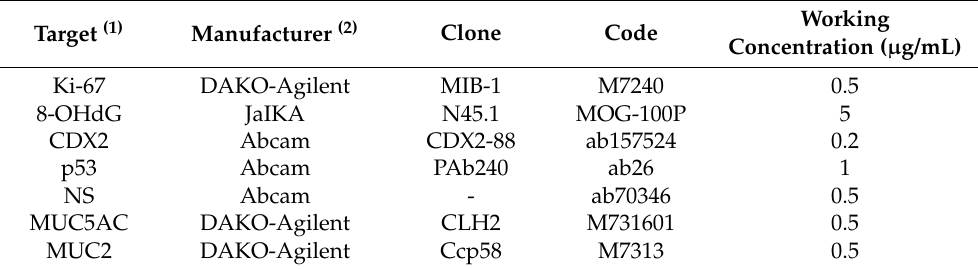
Table 4. Antibodies used for